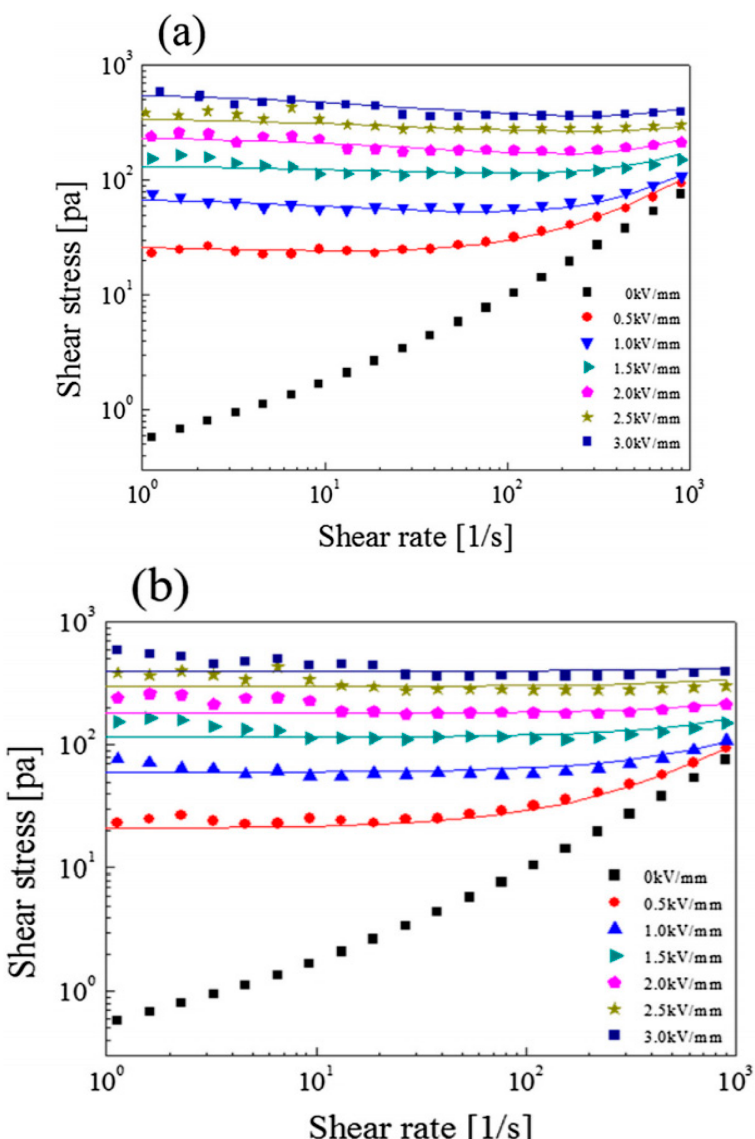
Figure 7. Flow curves of the stress of the phosphate MCC ER fluid under different electric field strengths: ( a )